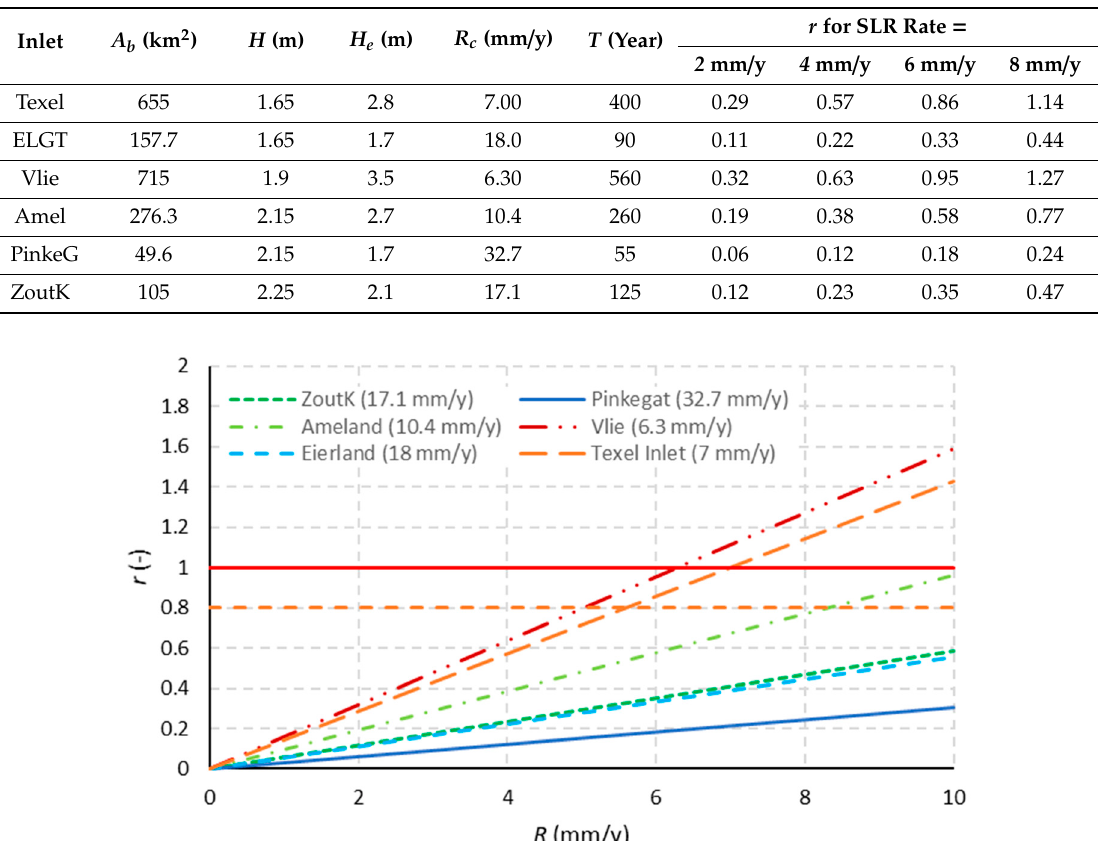
Figure 9. Dimensionless SLR rate r , i.e., normalized with the critical rate (given between brackets in the legend) as calculated in [21] for the tidal inlets in the Dutch Wadden Sea, increases linearly with the SLR rate R . The solid red line ( r = 1) indicates the initiation of drowning and the dashed orange line ( r = 0.8) indicates the level above which significant impact of SLR is expected. Table 1. Critical SLR rate for drowning of the various tidal inlet systems in the Dutch Wadden Sea from [21] and the dimensionless SLR rate r for four different SLR rates (2, 4, 6 and 8 mm/y). The equilibrium depth H e calculated using the empirical relations and the parameters for basin area A b and tidal range H are also given. The listed time scale T is calculated using the relation with R c and H e . Inlet